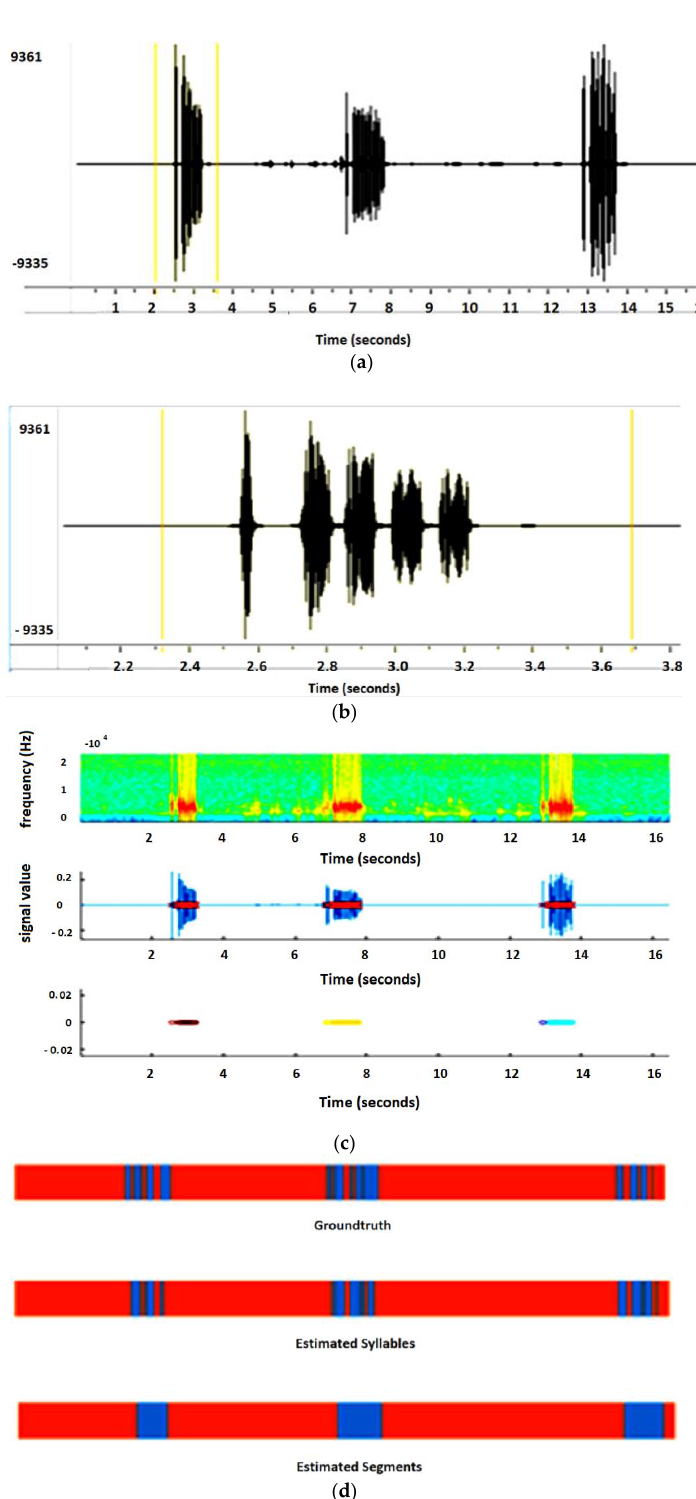
Figure 3. Performance analysis of segmentation algorithms for the monosyllabic bird (Tickell’s Leaf Warbler). ( a ) Syllables’ sequence of monosyllabic bird; ( b ) Zoomed view of first sequence of syllable for monosyllabic bird; ( c ) Results of segmentation with proposed approach; ( d ) Comparison of proposed approach with ground truth.